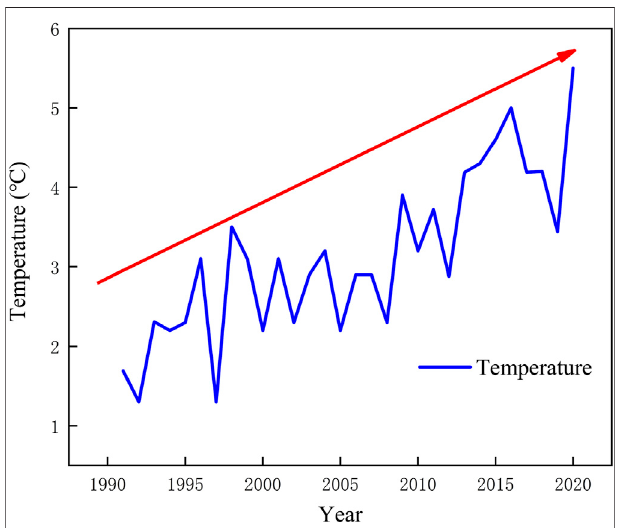
FIGURE 5 | Changes in annual precipitation and evaporation in Zabuye Salt Lake from 1991 to 2020.